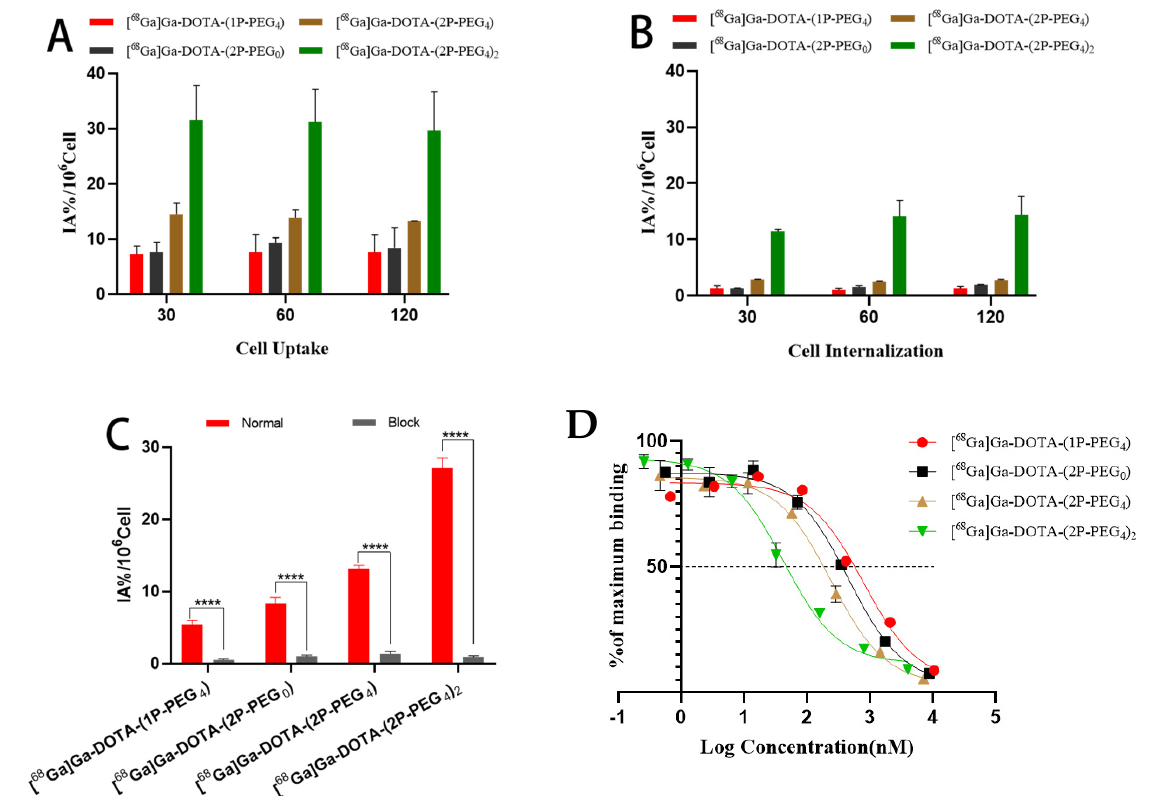
Figure 3. ( A ) Cellular uptake and ( B ) internalization of 68 Ga-labeled DOTA-(1P-PEG 4 ), DOTA-(2P- PEG 0 ), DOTA-(2P-PEG 4 ), and DOTA-(2P-PEG 4 ) 2 in PC-3 PIP cells at different time points, and ( C ) the uptake at one hour after cells were blocked by 2-PMPA (****: p < 0.0001). ( D ) Competitive binding affinity between 68 Ga-labeled ligands.